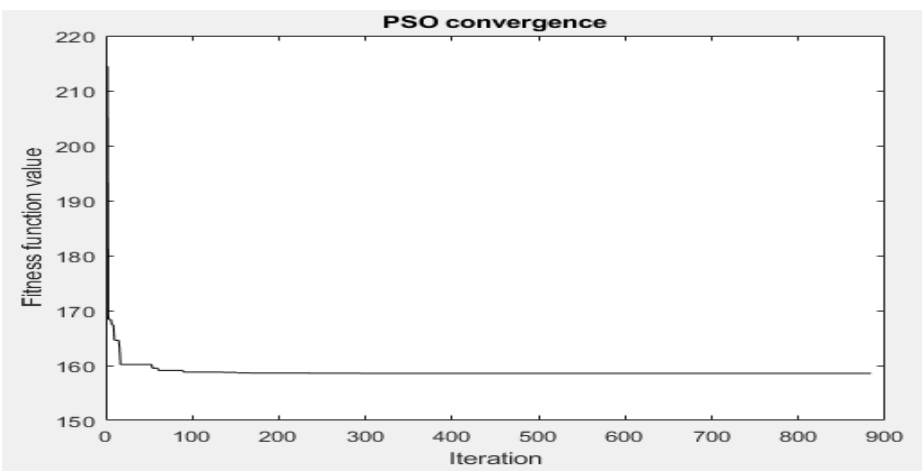
Figure 12. PSO Convergence